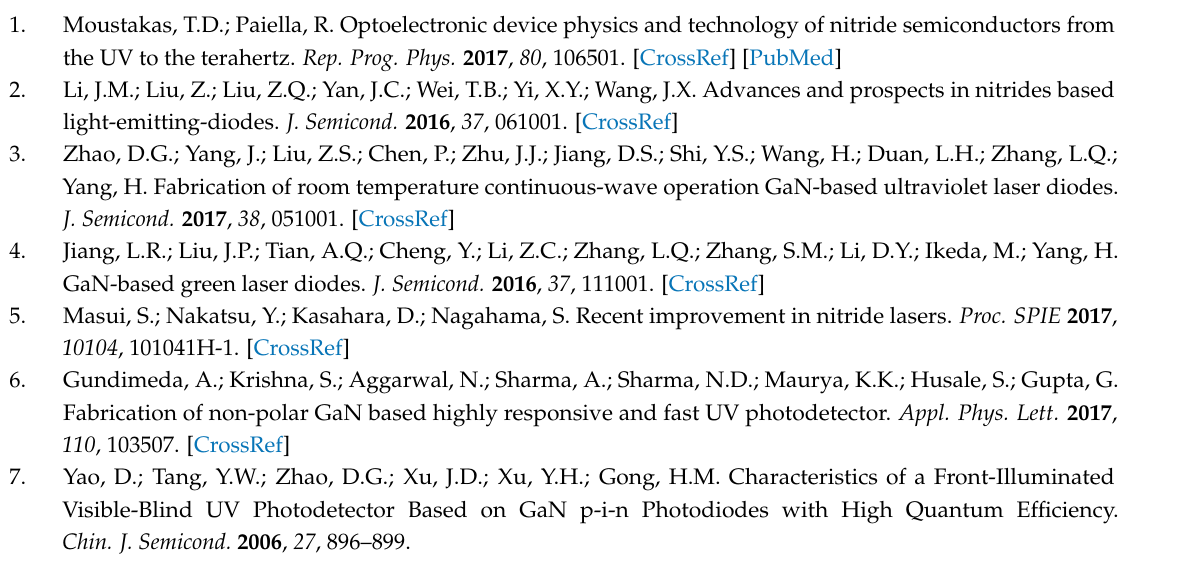
s1, Figure S1: Secondary ion mass spectroscopy results of carbon impurity in samples A0–I0, Figure S2: Secondary ion mass spectroscopy results of Si concentration in samples